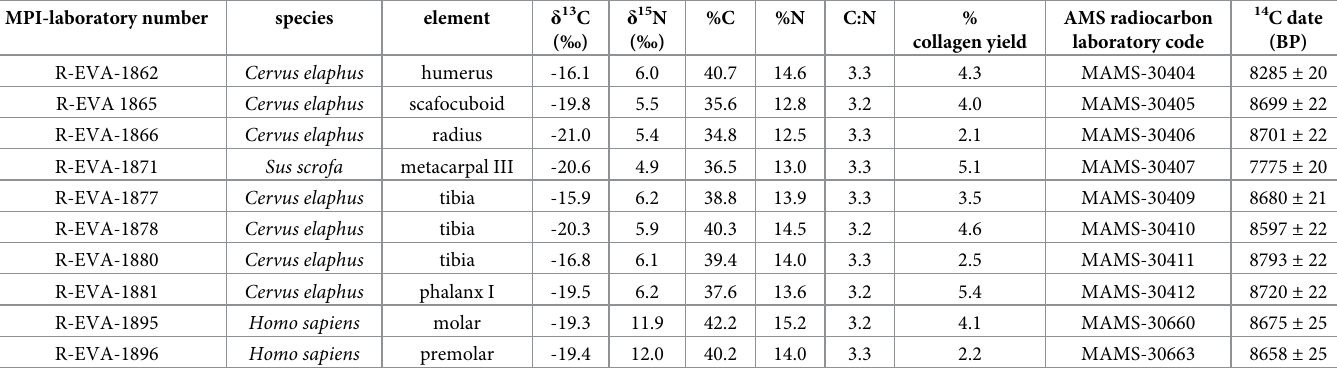
Table 1. Isotopic, elemental analyses and radiocarbon